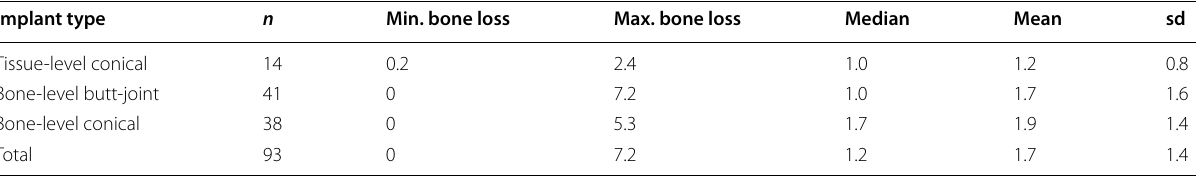
Presentation of minimal/maximal bone loss values at baseline (10 years) according to implant type sd standard deviation Table 6 Peri‑implant bone loss after 20 years